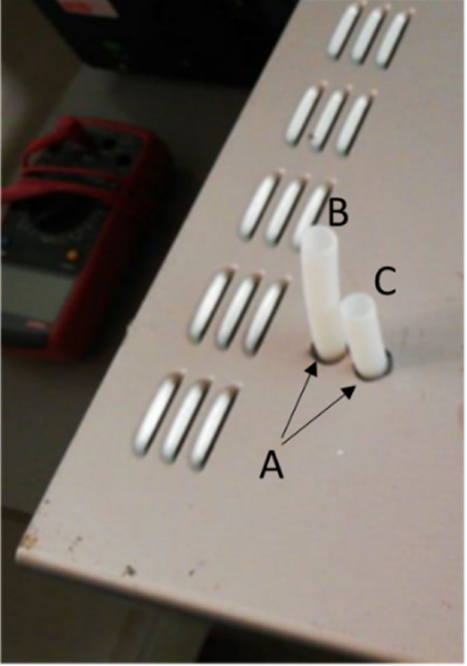
Figure 2. Modified microwave oven. A : Holes on the top of the microwave oven. B and C : Output and Input of